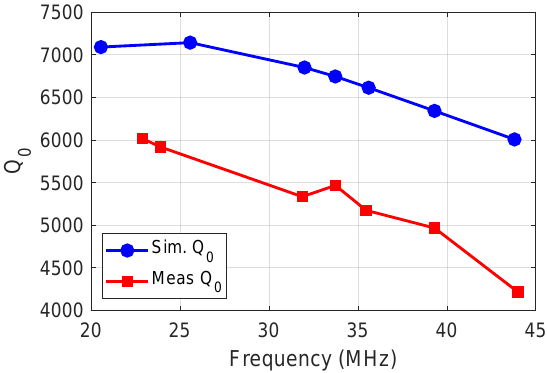
Figure 9. Cavity unloaded quality factors Q 0 vs. frequency. Blue curve refers to simulations while red curve reports measured